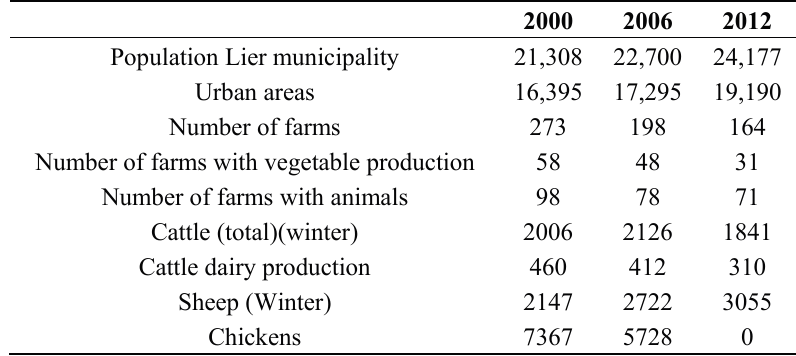
Table 4. Population, agriculture and farm animals in Lier municipality in year 2000, 2006 and 2012 (based on numbers from Statistics Norway